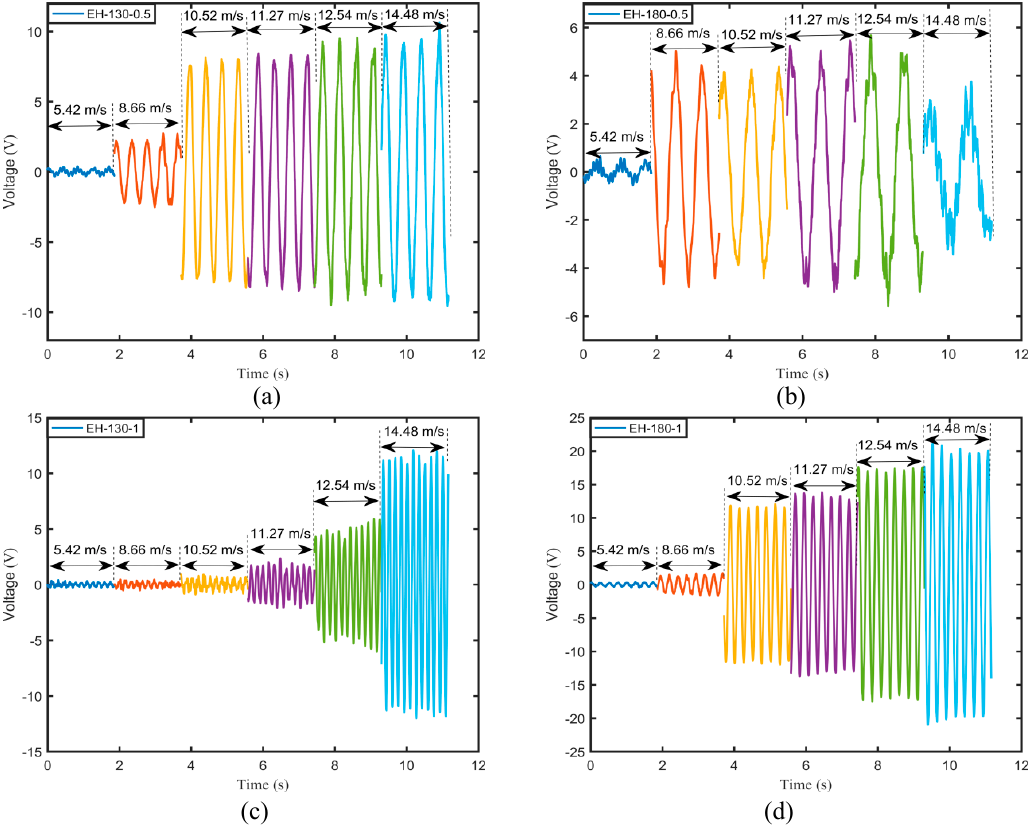
Figure 6. Variations of the time history of output voltage with airflow velocity for various harvesters: ( a ) EH-130-0.5; ( b ) EH-180-0.5; ( c ) EH-130-1; ( d ) EH-180-1.